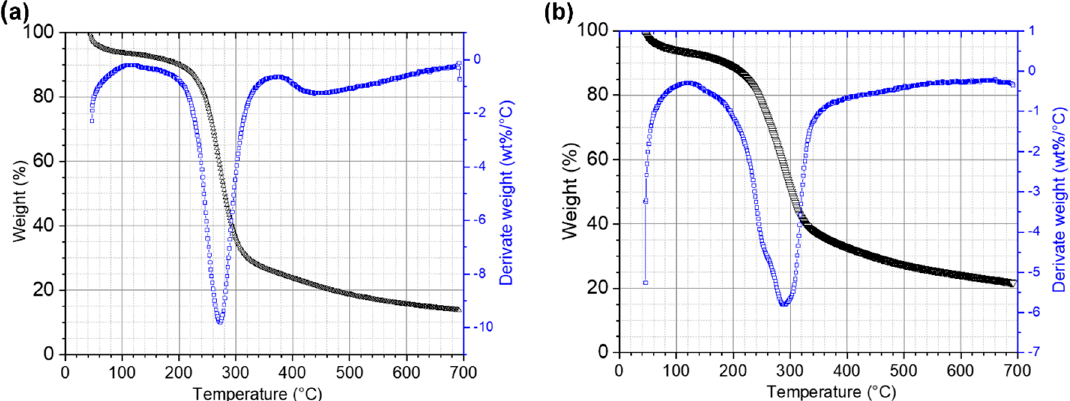
Figure 6. TGA and DTG curves of ramon flour. ( a ) RF control and ( b ) RF 12 days after inoculation.